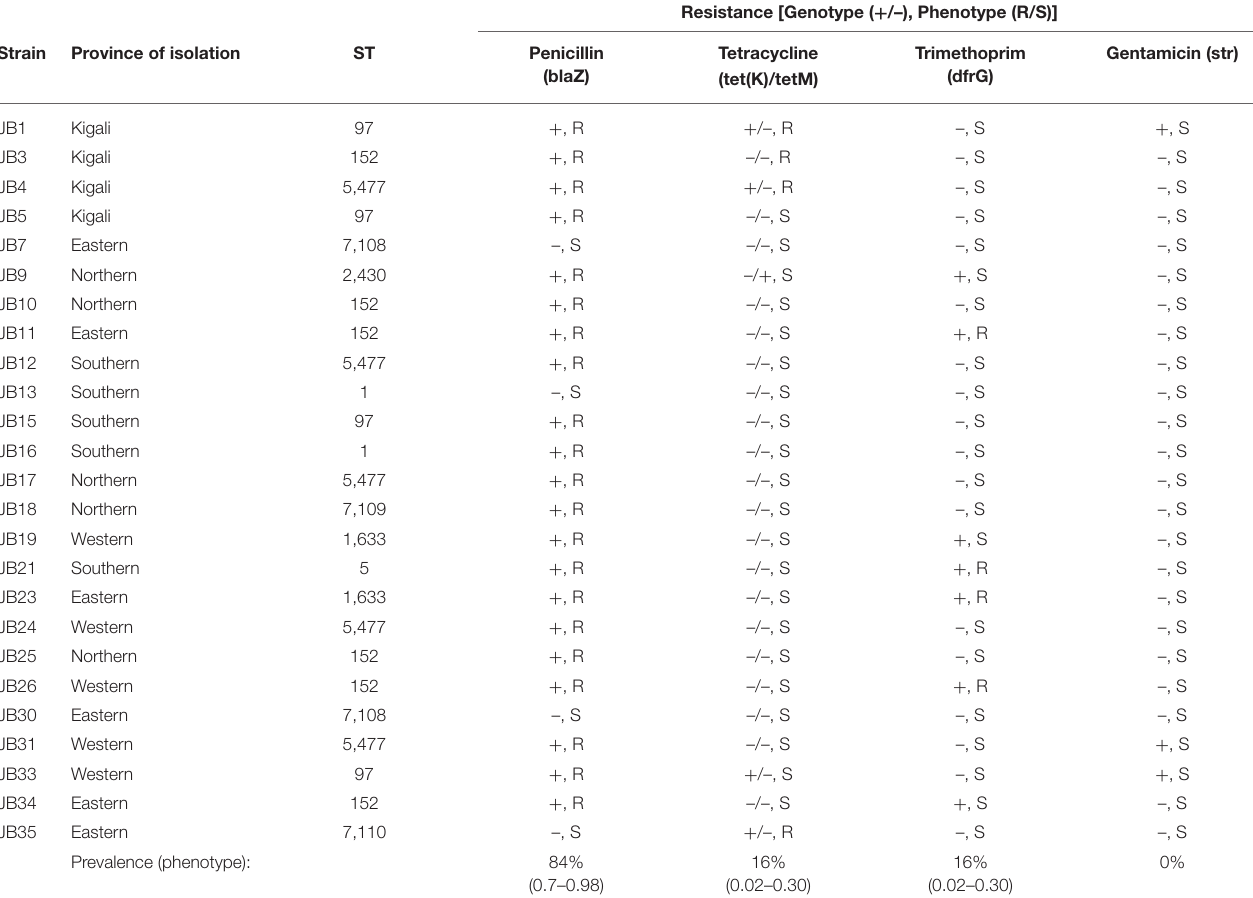
TABLE 1 | Antibiotic resistance profiling of the S. aureus strains obtained from subclinical mastitis cases in dairy cows from five regions in Rwanda. Resistance [Genotype ( + /–), Phenotype (R/S)] Strain Province of isolation ST Penicillin (blaZ)